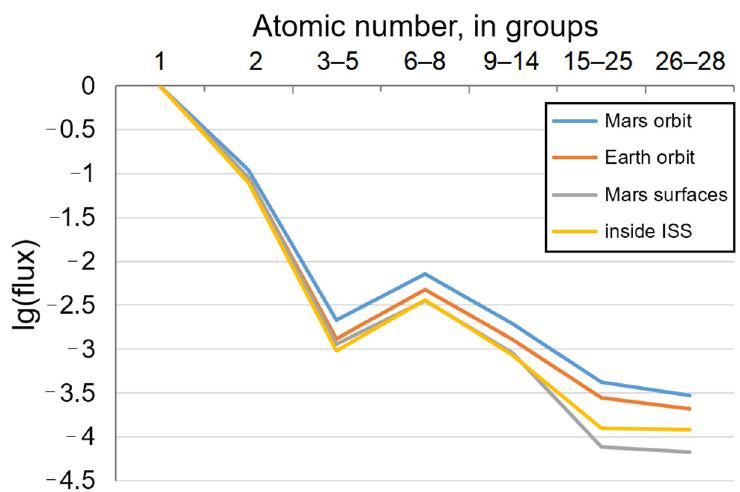
Figure 1. The flux of heavy-charged high-energy particles observed at several points in space: Mars orbit, Earth orbit, Mars surface, and inside the International Space Station (ISS). The data are presented as the decimal logarithm of the particle flux (ordered by groups by atomic number) relative to the proton flux taken as 1. Primary data taken from the following sources [29–32] .